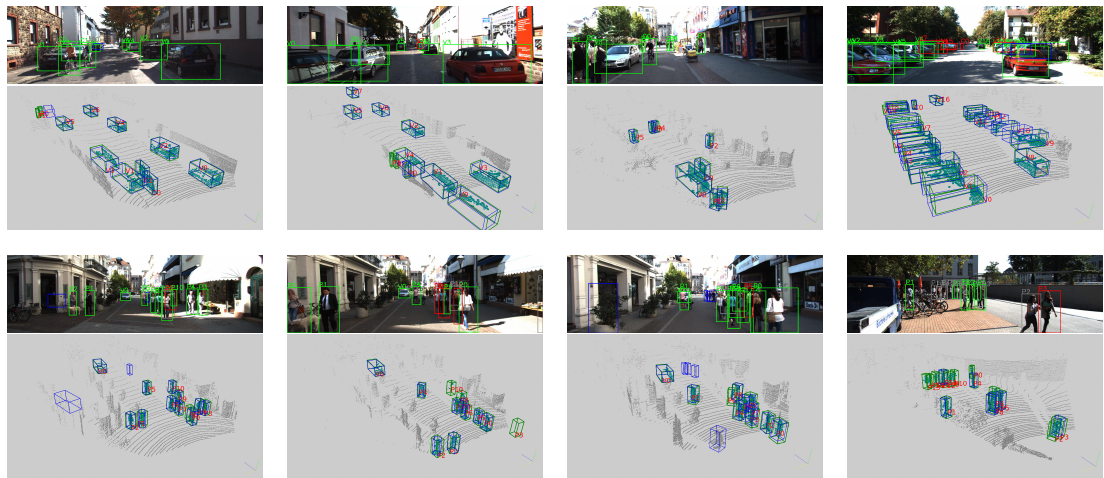
Figure 6. Results of detection on the KITTI validation set. In each image, a green box indicates successful detection, a red box indicates detection with low accuracy, a gray box indicates a false negative, and a blue box indicates a false positive. The digit and letter beside each box represent the instance ID and the class, respectively, with “V” denoting a car, “P” denoting a pedestrian and “C” denoting a cyclist. In the point clouds, green boxes indicate ground truths, and blue boxes indicate detection